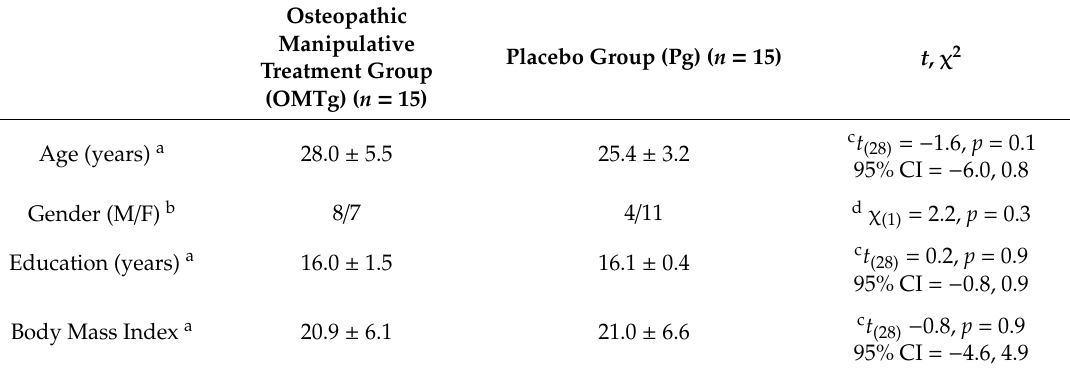
Table 1. Participants’ demographic characteristics.